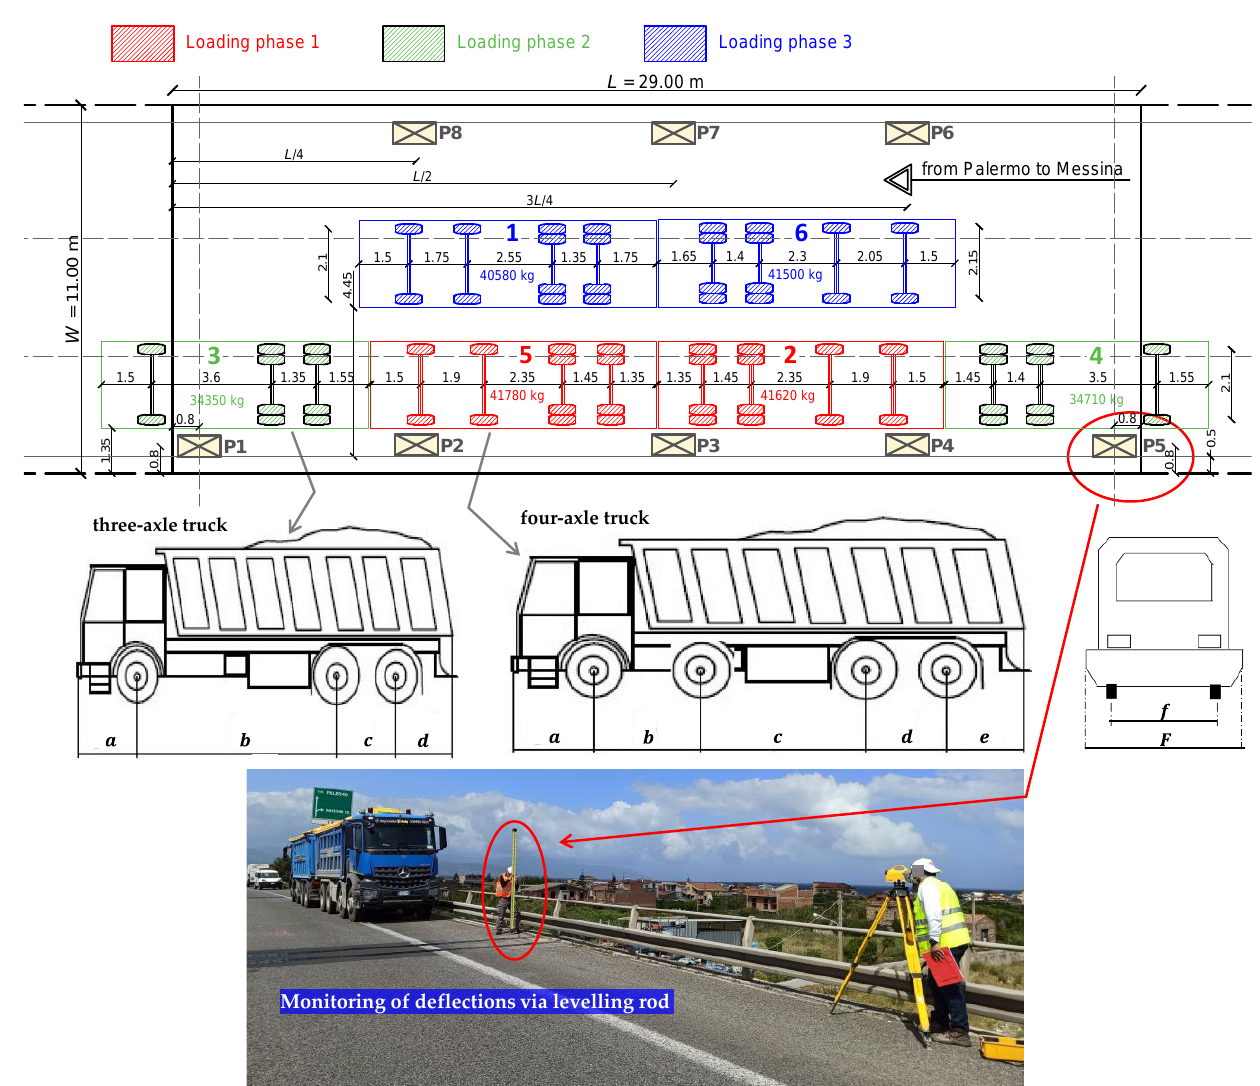
Figure 13. Plan of static load tests on the Longano viaduct deck with location of eight measurement points of displacement (P1 – P8) and actual arrangement of three-axle and four-axle heavy trucks in three subsequent loading phases. Table 4. Characteristics of the heavy trucks used for the load tests on the Longano viaduct.